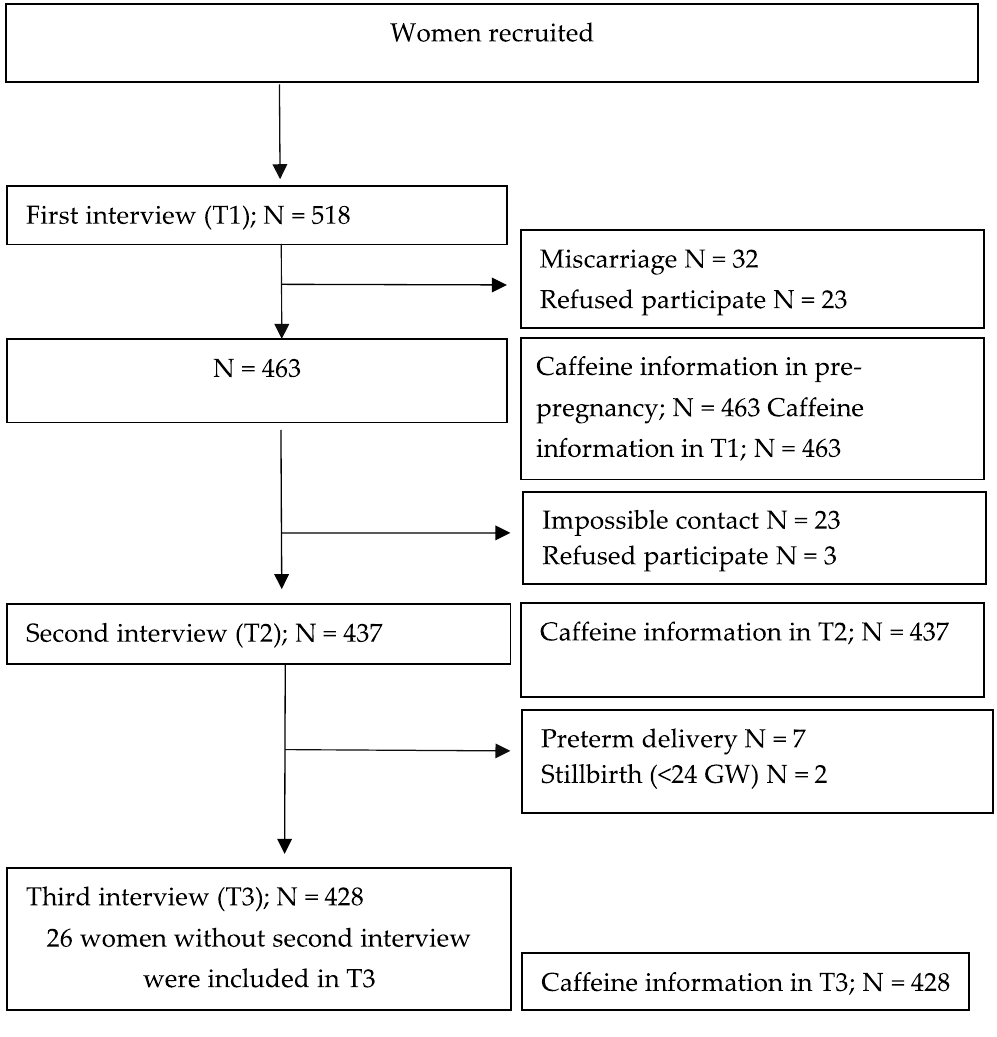
Figure 1. Cohort flow chart.